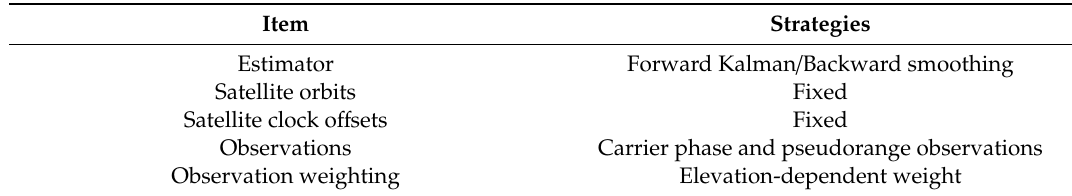
Table 1. Processing strategies for the multi-GNSS (Global Navigation Satellite System) troposphere